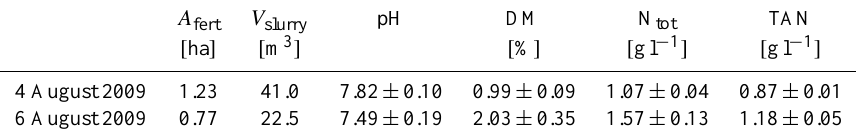
Table 2. Characteristics of the applied slurry: A fert =fertilised area, V slurry =volume of applied slurry, DM=dry matter content, N tot